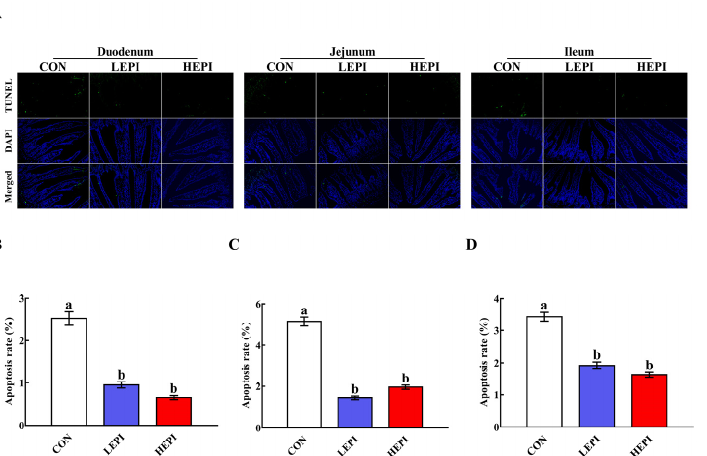
Figure 3. Effects of epicatechin on intestinal cell apoptosis in mice. ( A ) Representative small intestinal cross-sections of mice in the CON, LEPI, and HEPI groups after TUNEL staining (200×). Nuclei were stained with DAPI (blue) and TUNEL (green) staining. ( B − D ) Quantification of apoptotic cells in the duodenum, jejunum, and ileum. Data are expressed as means (eight mice/treatment), with standard errors represented by vertical bars. a, b Mean values with different superscripts indicate a significant difference ( p < 0.05). CON group: control group—mice received a standard diet; LEPI group—mice received a standard diet supplemented with 50 mg/kg epicatechin; HEPI group—mice received a standard diet supplemented with 100 mg/kg epicatechin; DAPI—4 ′ , 6-diamidino-2-phe-